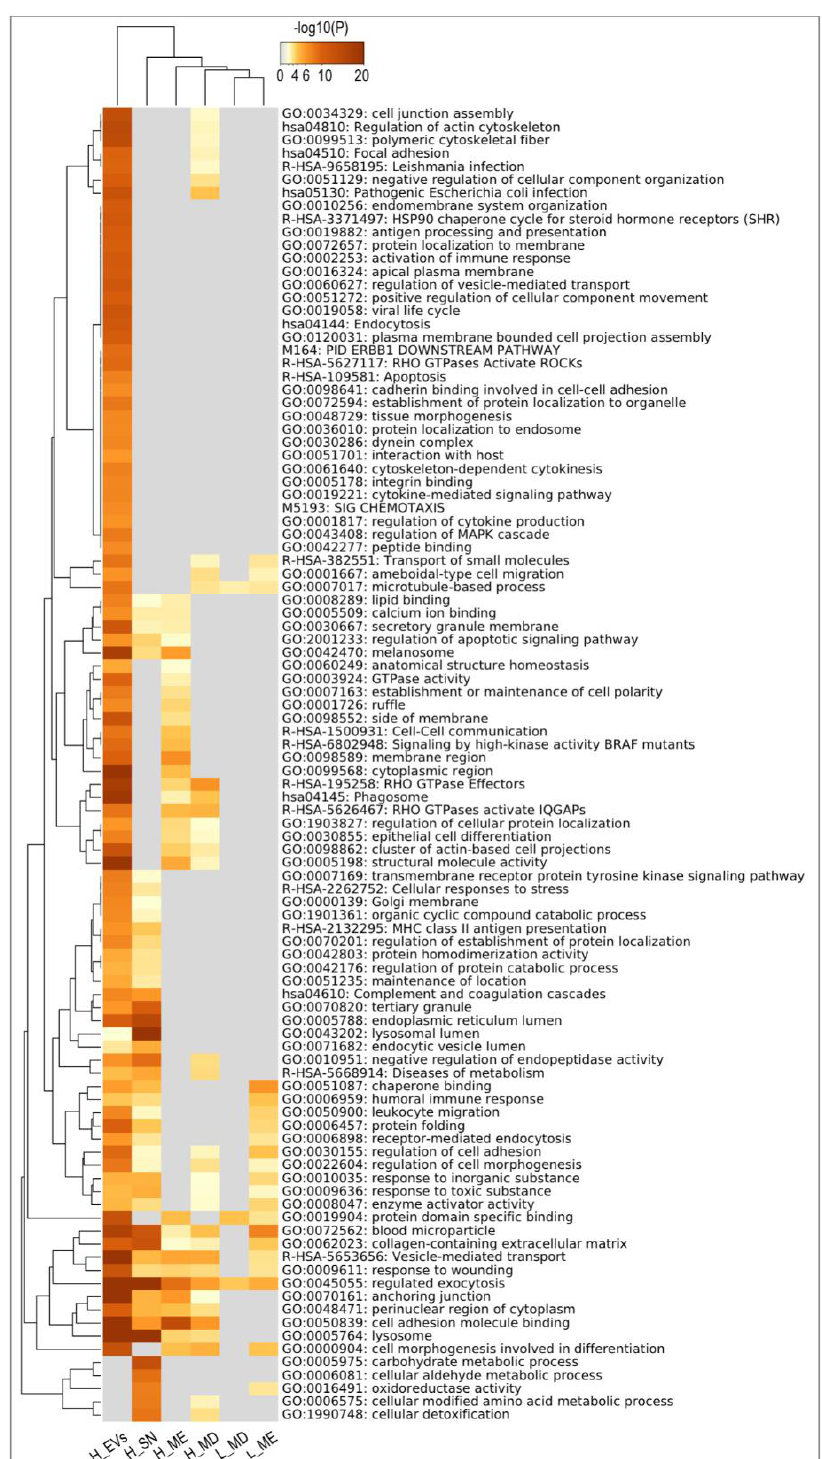
Figure 6. Functional enrichment analysis for proteins identified by mass spectrometry using the Metascape tool. Heatmap visualization of selected enriched terms across protein lists categorized as follows: (H_EVs) proteins highly enriched in EVs obtained by all methods; (H_MD) proteins highly abundant in MD_CE/TRE; (H_ME) proteins highly abundant in ME_CE/IZON/UC; (L_MD) proteins low abundant in MD_CE/TRE; (L_ME) proteins low abundant in ME_CE/IZON/UC; and (H_SN) proteins highly enriched in supernatant (SN). Bar graph of enriched terms across differentially abundant proteins colored by p -values representing enriched clusters up to a score of